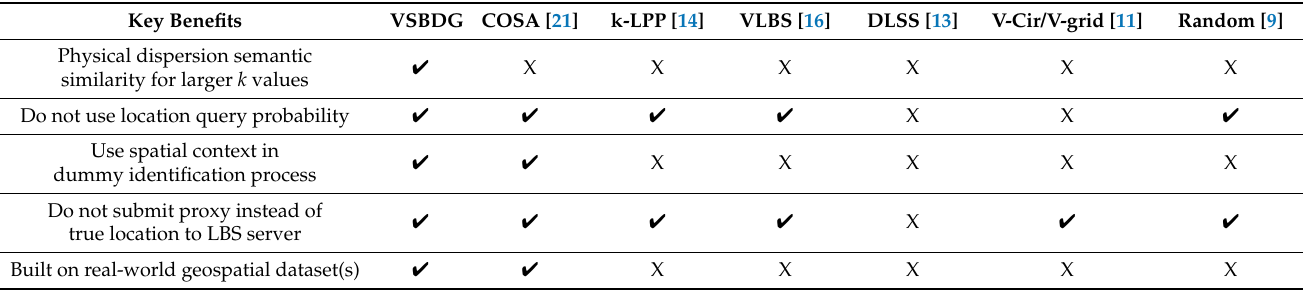
Table 7. A comparison of benefits addressed by the proposed (VSB) and the existing dummy